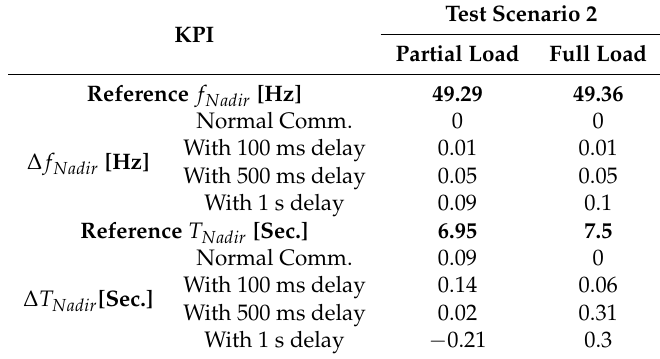
Table 8. Comparison of ( a ) f Nadir and ( b ) T Nadir obtained in Test Scenario -2 with that of Reference Frequency Response.